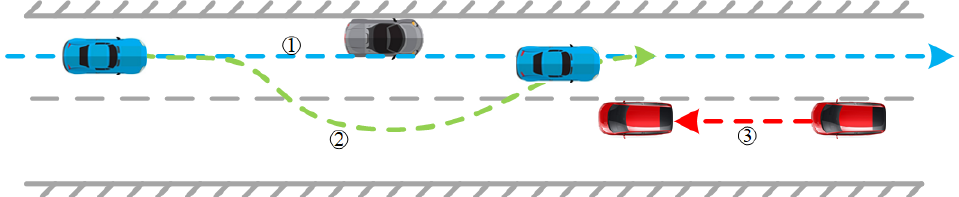
Figure 1. Target scenario of collision avoidance overtaking a parked vehicle and yielding an Figure 1. oncoming vehicle.